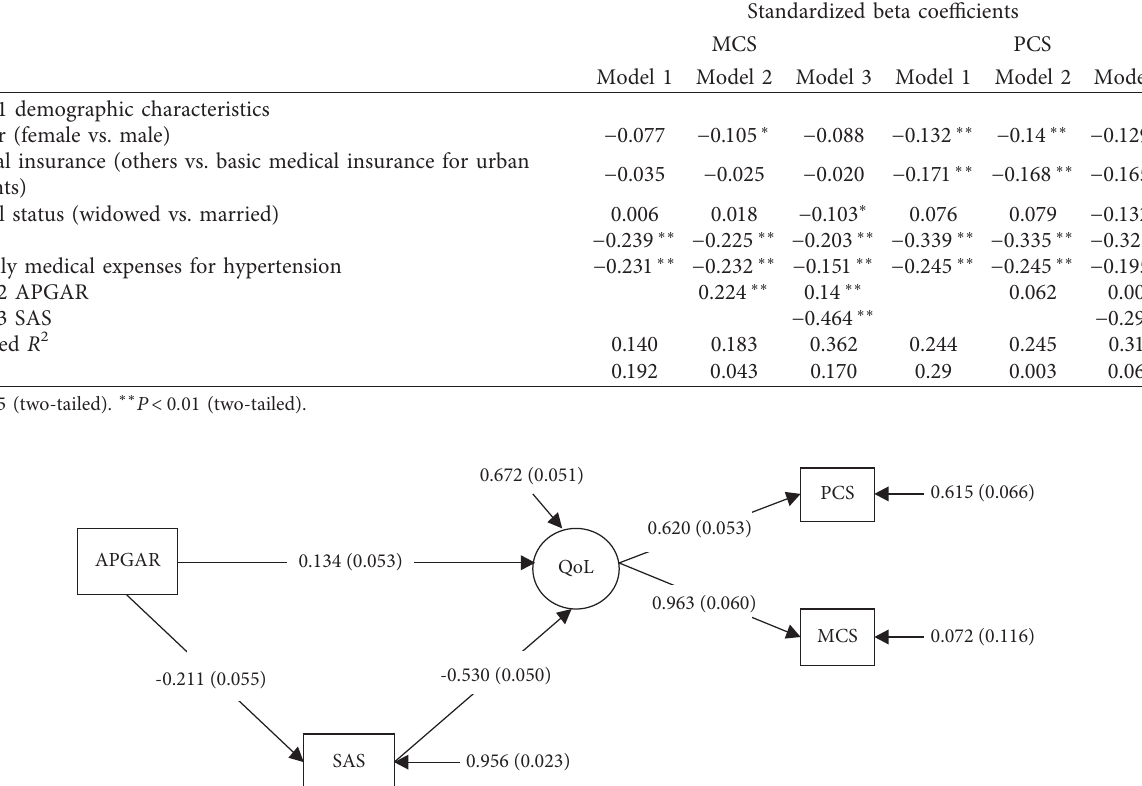
Figure 2: The mediation model. APGAR: family function; SAS: anxiety; QoL: quality of life; PCS: physical component score; MCS: mental component score. Chi-square � 2.893 ∗ , P � 0 . 089; RMSEA (root mean square error of approximation) � 0.072; CFI � 0.992; TLI � 0.953; SRMR (standardized root mean square residual) �